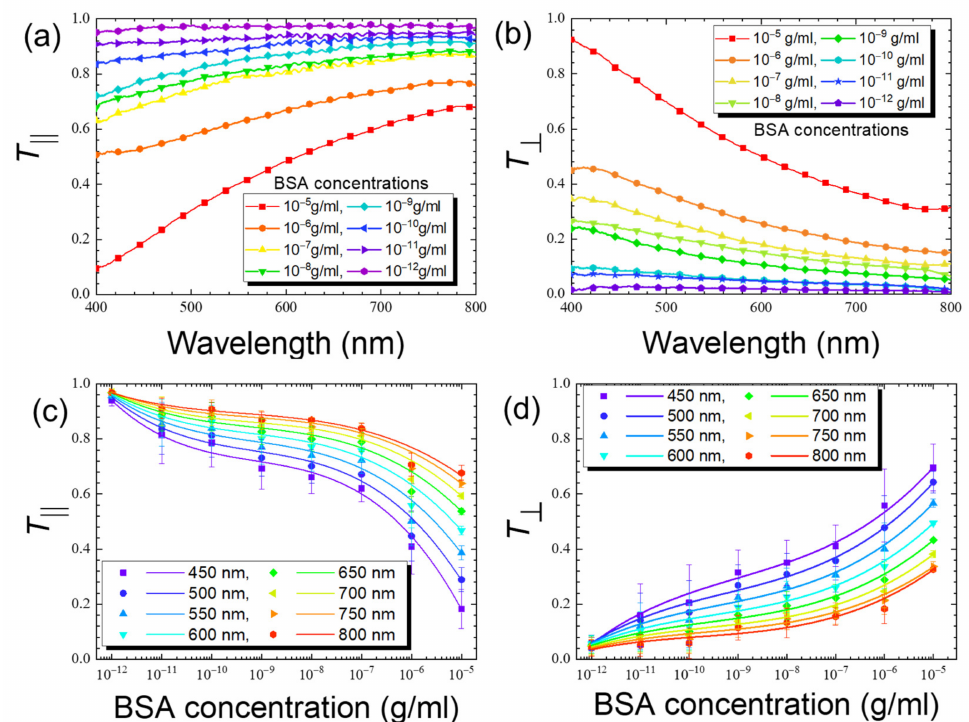
Figure 5. Reduced transmission data of LCLC with 14-wt% DSCG in the presence of BSA at various concentrations ranging from 10 − 12 to 10 − 5 g/mL. The reduced transmittance parameters ( a ) T (cid:107) and ( b ) T ⊥ in the wavelength range of 400–800 nm at various BSA concentrations and ( c ) T (cid:107) and ( d ) T ⊥ plotted against BSA concentration at selected wavelengths of 450, 500, 550, 600, 650, 700, 750, and 800 nm for quantitative purpose. T (cid:107) and T ⊥ correspond to the respective parallel polarizer and crossed polarizer schemes for the spectrometric detection, respectively. Error bars represent standard deviations ( n ≥